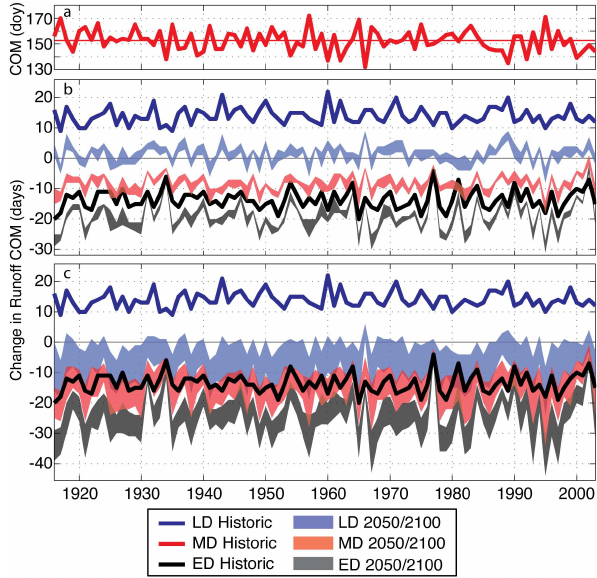
Fig. 10. As in Fig. 6, but showing (a) runoff center of mass for MD historic, and change in COM for 2050 (b) and 2100 (c) . Table 6. Day of and change in runoff center of mass (COM) relative to historic climate with moderate dust loading (MD historic).